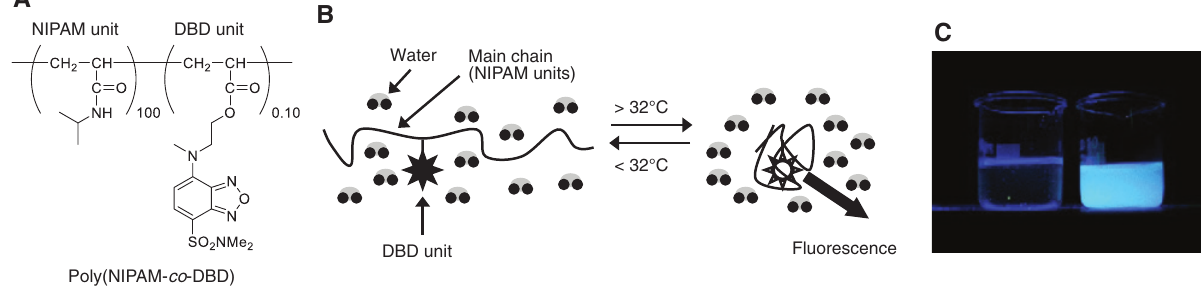
Figure 5: Highly sensitive fluorescent polymeric thermometer. (A) Chemical structure of poly(NIPAM- co -DBD). (B) Functional mechanism of poly(NIPAM- co -DBD). (C) Fluorescence photograph of = 39,400, M = 27,600, M = 1.43) in water (left: cold, right: poly(NIPAM- co -DBD) ( M / M w n w n